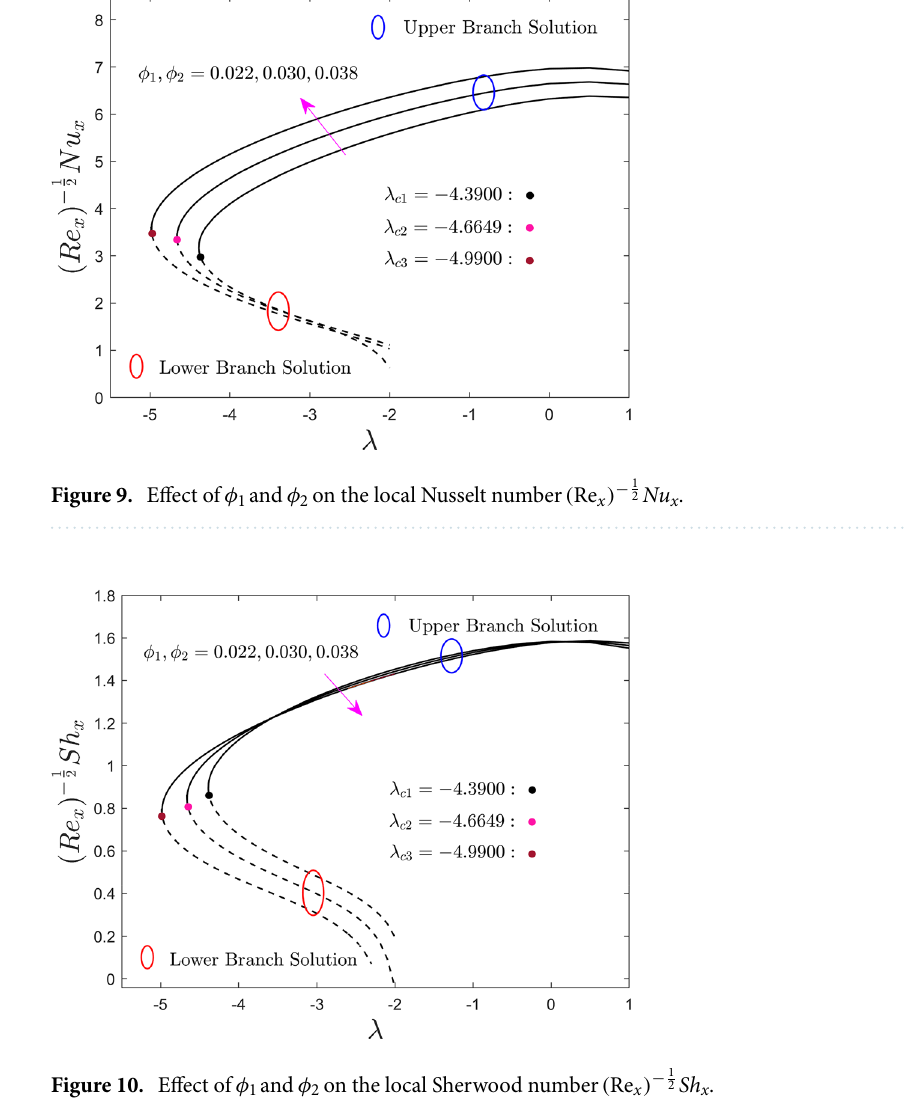
Figure 10. Effect of φ 1 and φ 2 on the local Sherwood number ( Re x ) −